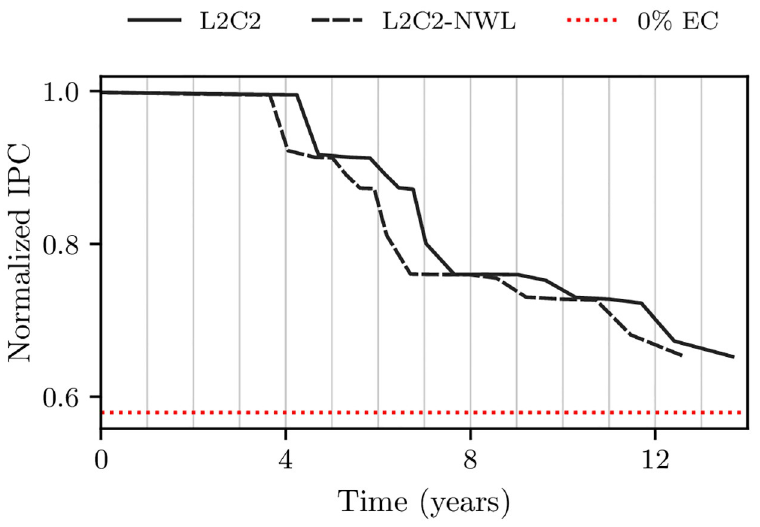
Fig 13. IPC evolution until losing 50% of capacity of an L2C2 without intra-frame wear-leveling mechanism, L2C2-NWL, for cv = 0.2.